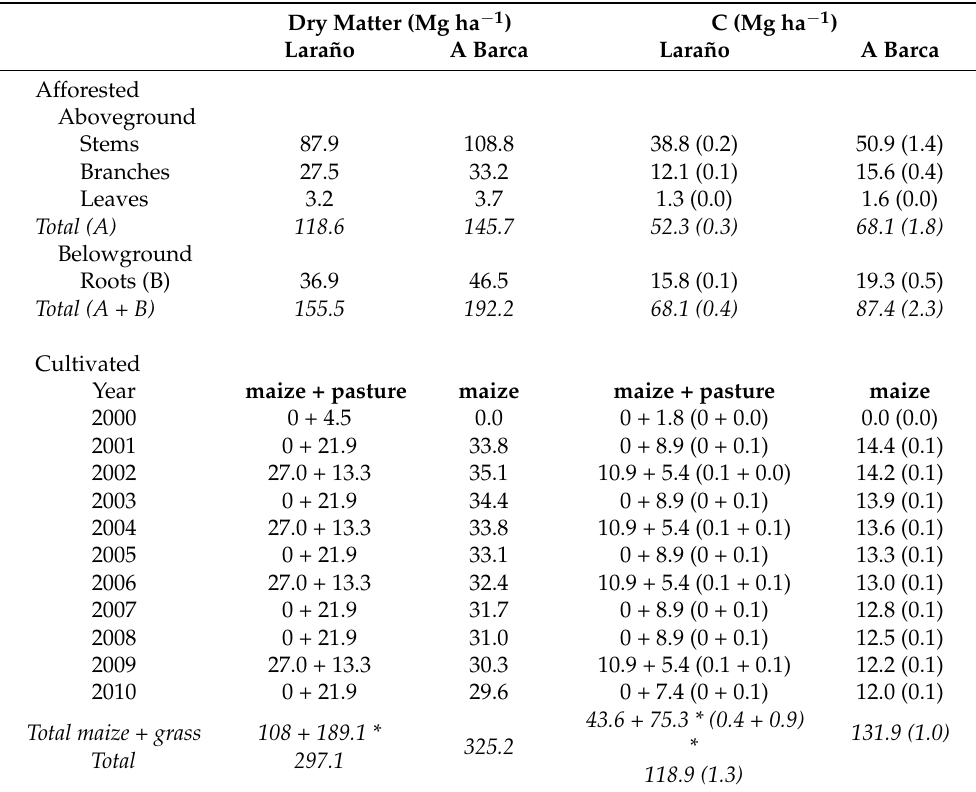
* first figure maize, second figure,